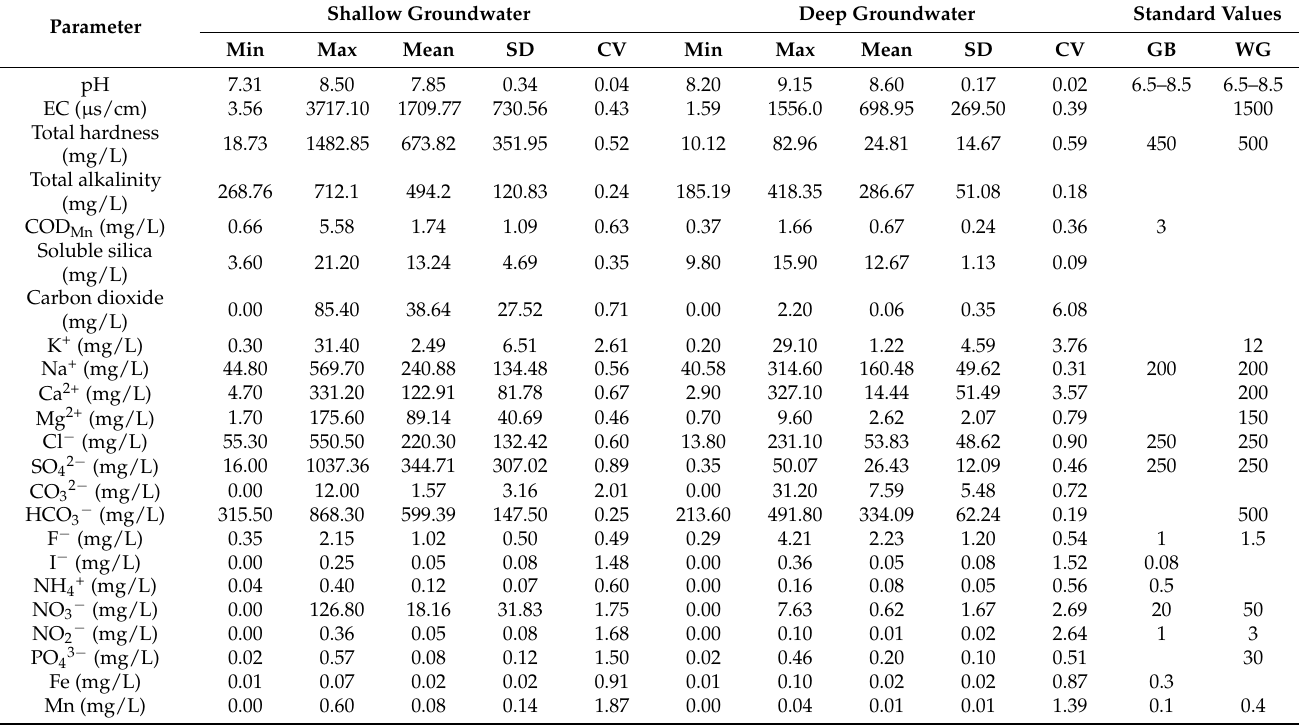
Table 4. Statistical summary of hydrochemical characteristics of